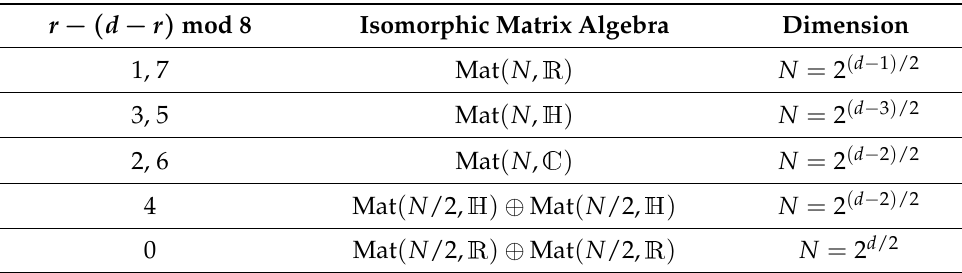
Table 4. Classification of even subalgebras of real Clifford algebras C l + ( r , d − r , R ) in terms of isomorphic real, complex or quaternionic matrix